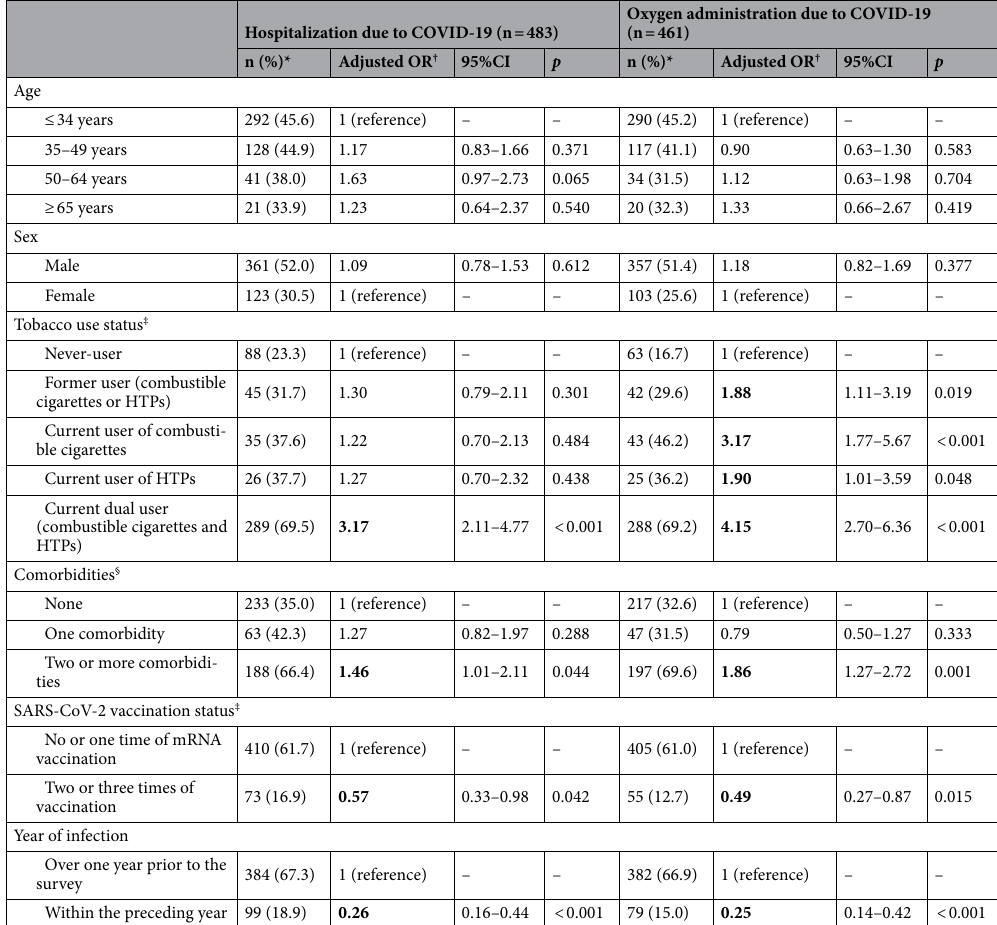
Table 3. Factors associated with hospitalization and oxygen administration due to COVID-19 among participants infected with SARS-CoV-2 once (n = 1097). *Percentages of individuals who hospitalized (left column)/administered oxygen (right column) among those infected once in each category. † Estimated using multivariable logistic regression modeling with adjustment for all listed variables. Values of p < 0.05 were considered statistically significant and corresponding adjusted ORs are shown in bold. ‡ Reflected the status at the time of the survey for infection within the preceding year and the status at one year prior to the survey for infection over one year prior to the survey. § 12 diseases listed in Table 1. COVID-19 coronavirus disease 2019, n number (weighted by inverse probability weighting), OR odds ratio, CI confidence interval, HTPs heated tobacco products, SARS-CoV-2 severe acute respiratory syndrome coronavirus 2, mRNA messenger ribonucleic